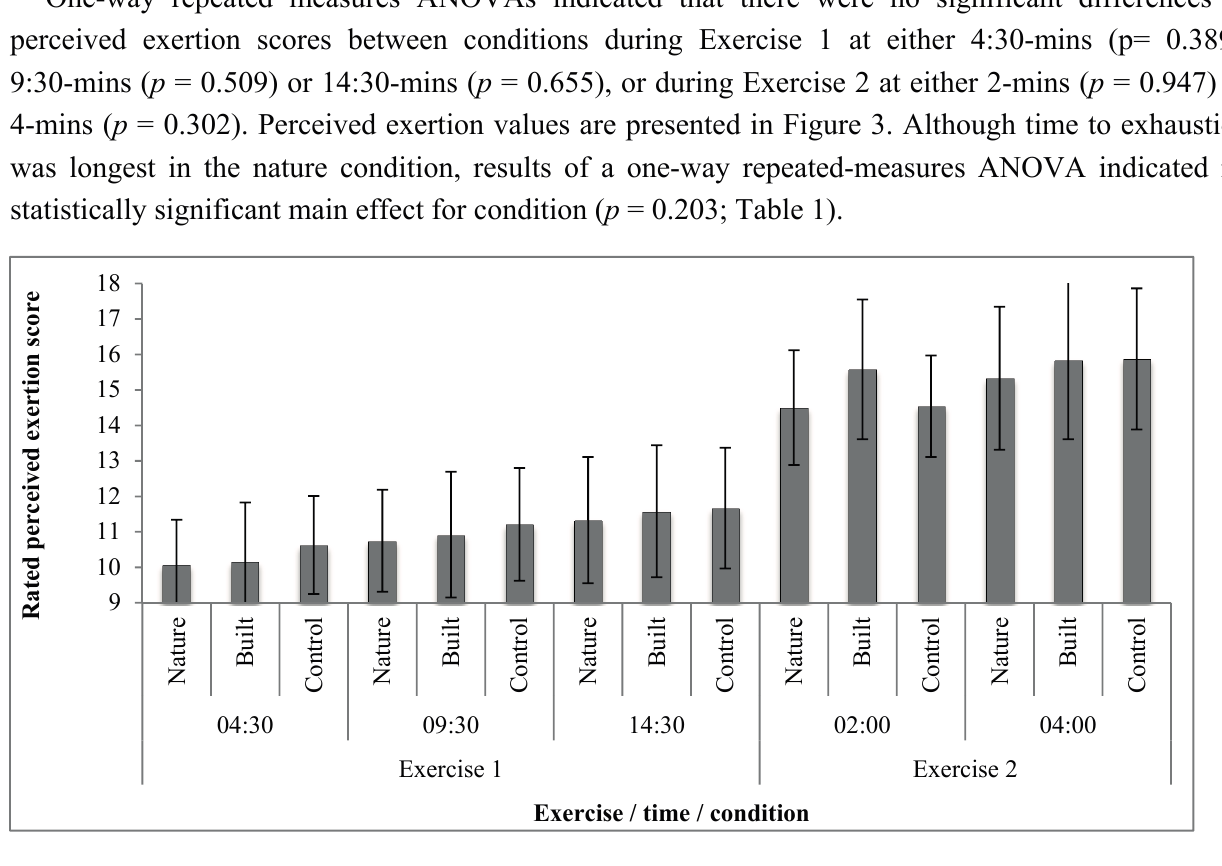
Figure 3. Perceived exertion scores by exercise bout, time and condition; Rated perceived exertion: minimum value = 6 (no exertion at all), maximum value = 20 (maximal